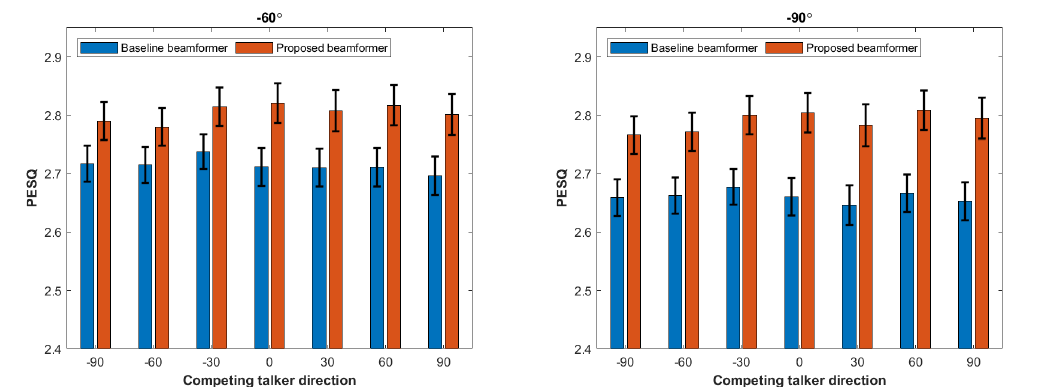
Figure 7. Average PESQ scores and 95% confidence intervals for the outputs of the baseline and proposed beamformers depending on the azimuths of the desired source and a competing talker with an RT60 of 300 ms.